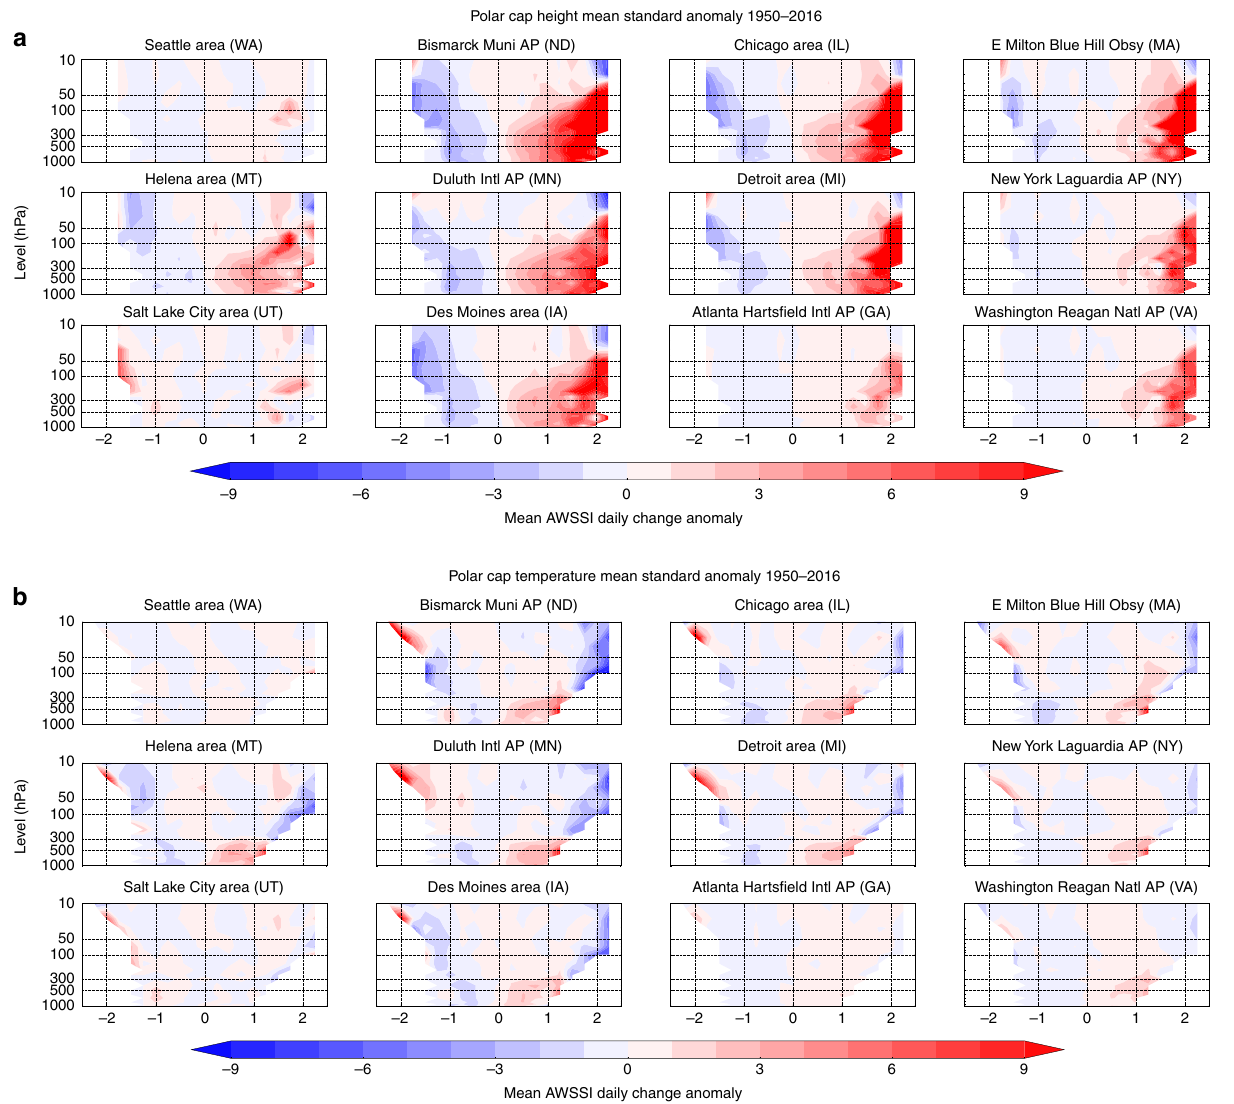
Fig. 2 Warm Arctic related to increased severe winter weather. The departure from the winter average in daily change in the AWSSI (Accumulated Winter Season Severity Index) at several weather stations across the US during December – February shown at all levels between 1000 and 10 hPa. AWSSI is plotted with composited values of the polar cap geopotential height (PCH, a ) and air temperature (PCT, b ) standardized anomalies from the surface to the mid-stratosphere (10 hPa), north of 65° N, from 1950 to 2016. Anomalies computed relative to climatology from 1981 – 2010. Results for all stations are consistently statistically signi fi cant at p < 0.01. Statistical signi fi cance for both PCH and PCT at selected levels for all cities shown in Supplementary Table